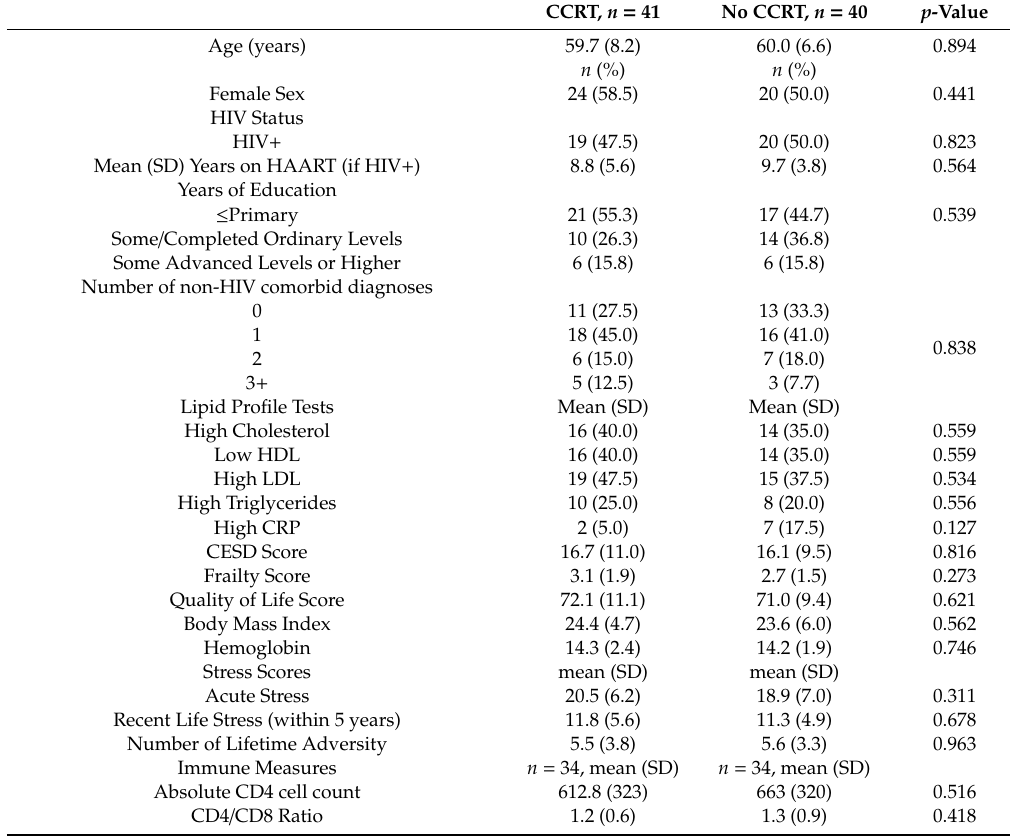
Table 1. HIV-infected and demographically matched HIV-negative community dwelling adults 50–87 years old from the Wakiso District of Uganda non-randomly allocated CCRT vs. No CCRT for evaluation of intervention